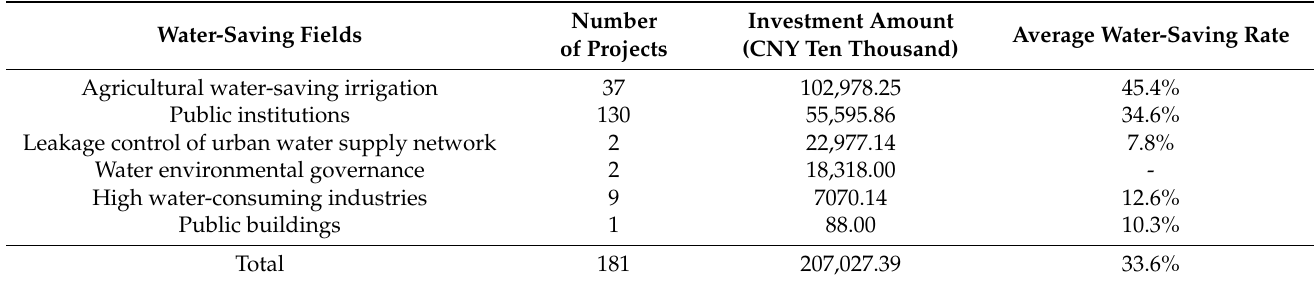
Table 1. The implementation of WSMC projects between 2016 and